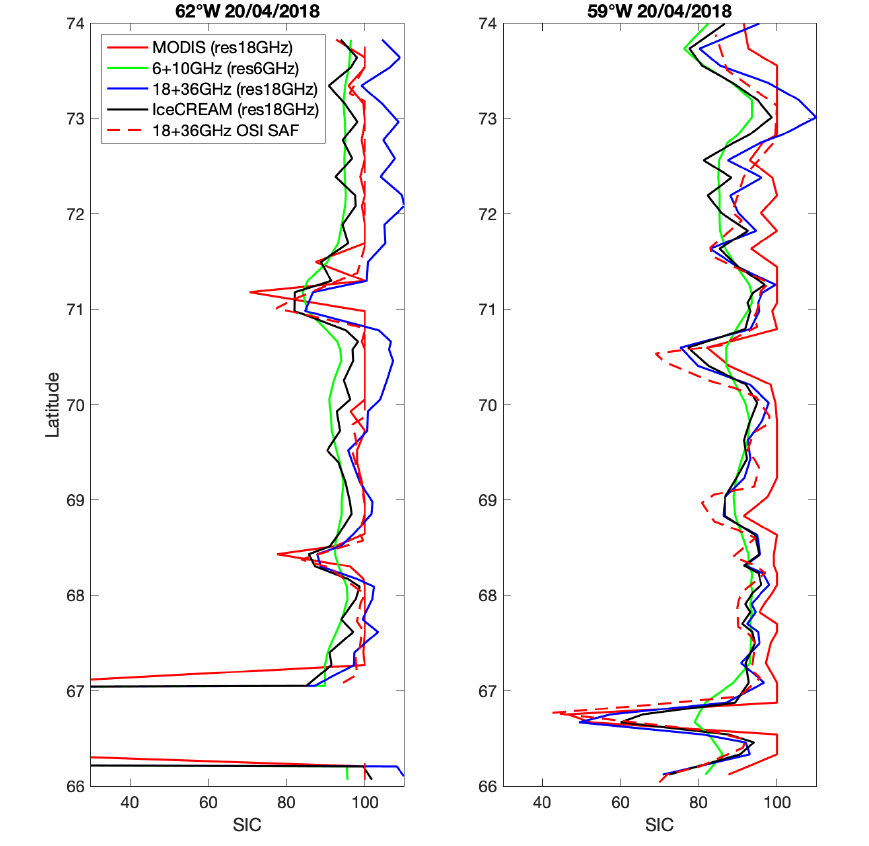
Figure 8. Transects over the scene, for different SIC estimates. Left: at 62 ◦ W. Right: at 59 ◦ W. The following products are compared: the MODIS estimates at 18 GHz resolution, our AMSR2 retrieval at 6+10GHz (at the spatial resolution of the 6 GHz) and at 18+36GHz (at the spatial resolution of the 18 GHz), the combination of these two results (the IceCREAM all channel results at the spatial resolution of the 18 GHz), and the OSI SAF operational